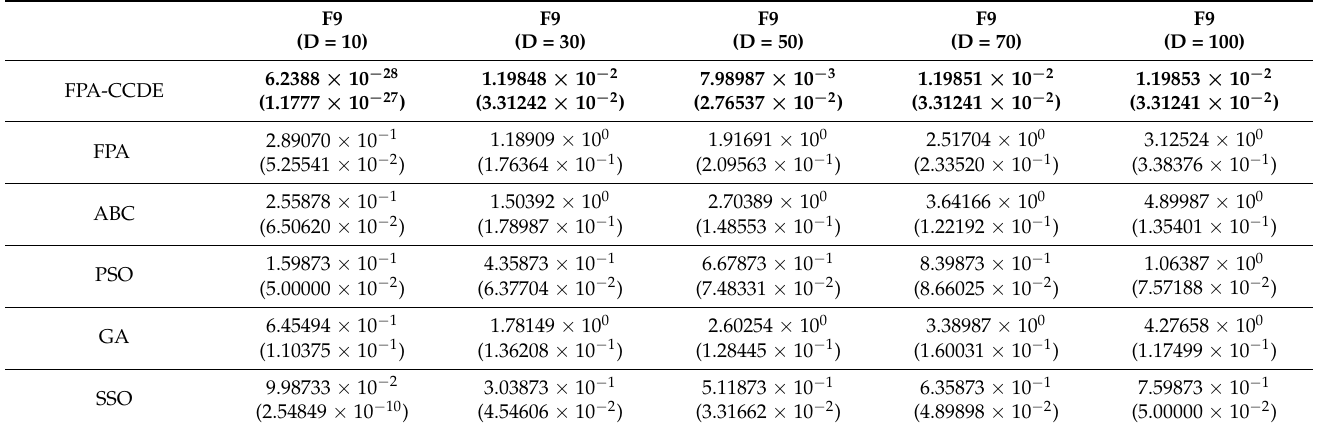
Table 4. F9 with the increase of variables dimension.